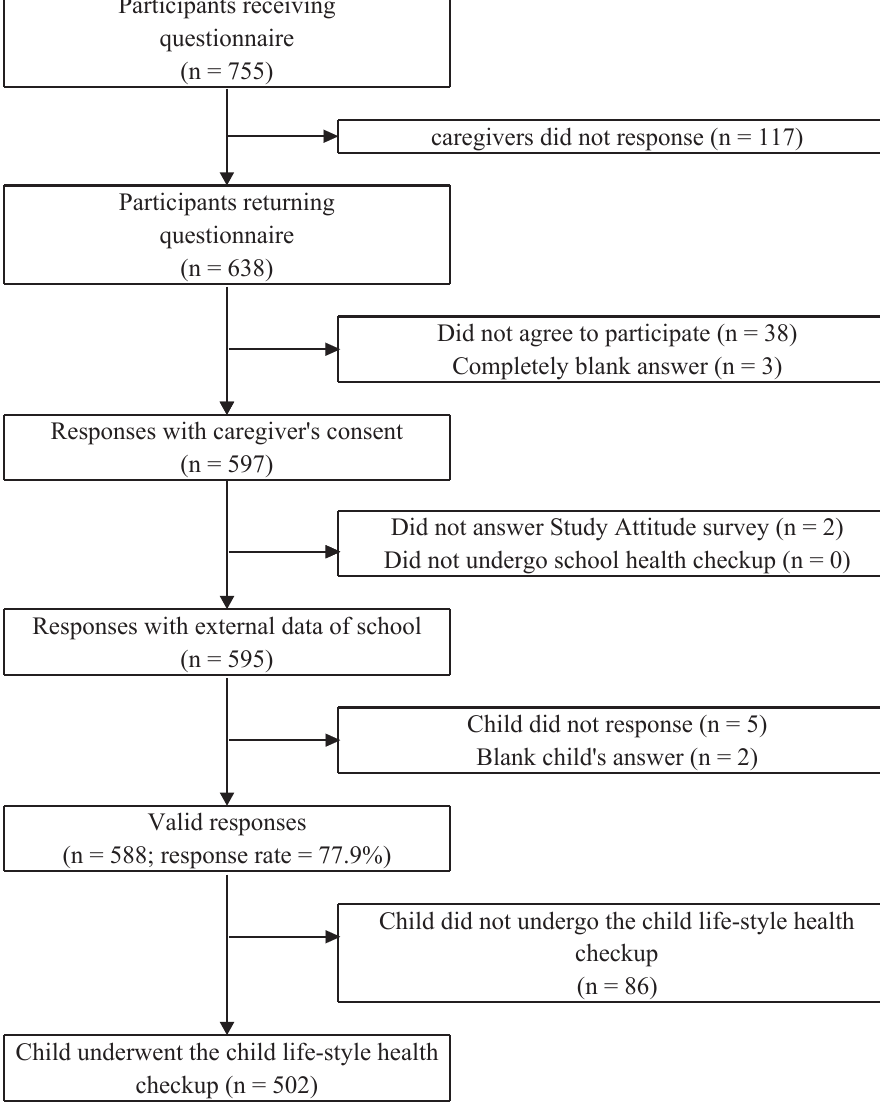
Figure 3. Flowchart of the analytical sample of A-CHILD in the second wave in